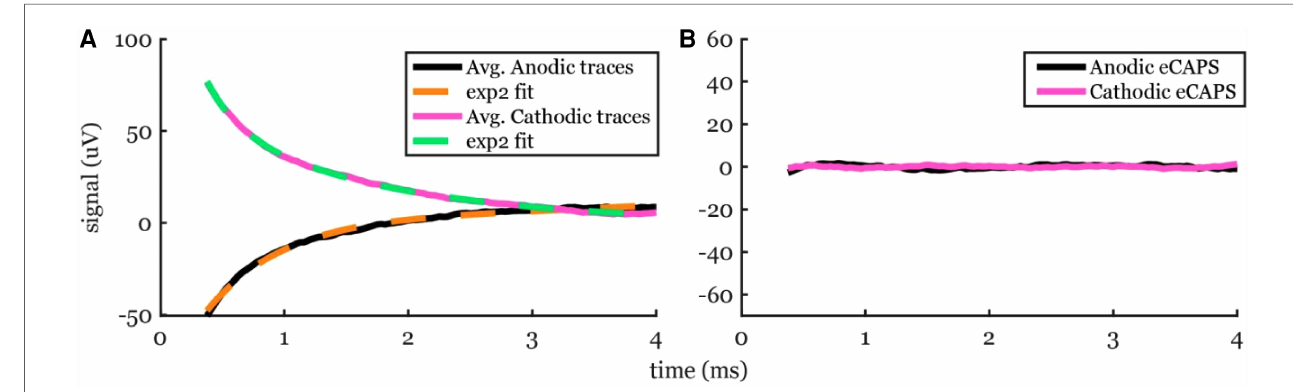
FIGURE 6 Artifact removal using exp2 fi t to a recording from a subthreshold 1-mA stimulation in participant #2. ( A ) The averaged traces (solid lines) and the best- fi t curves (dashed lines). ( B ) No ECAP was observed, as